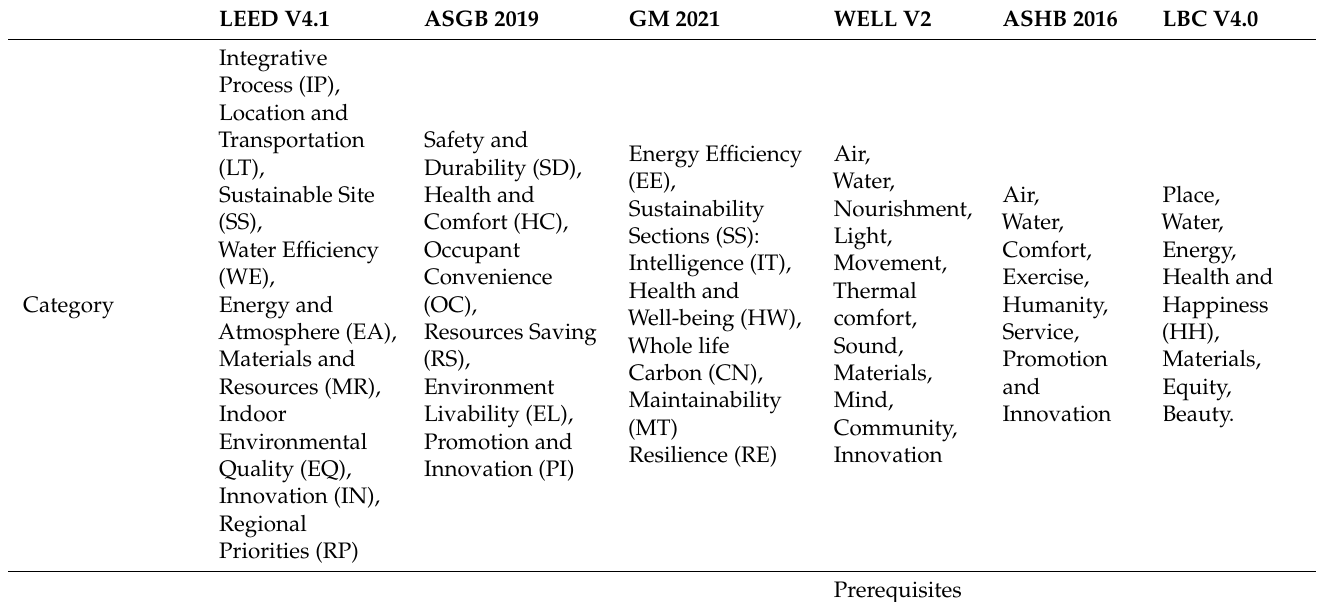
Table 1. General information of six selected GBRSs. (Source: by the